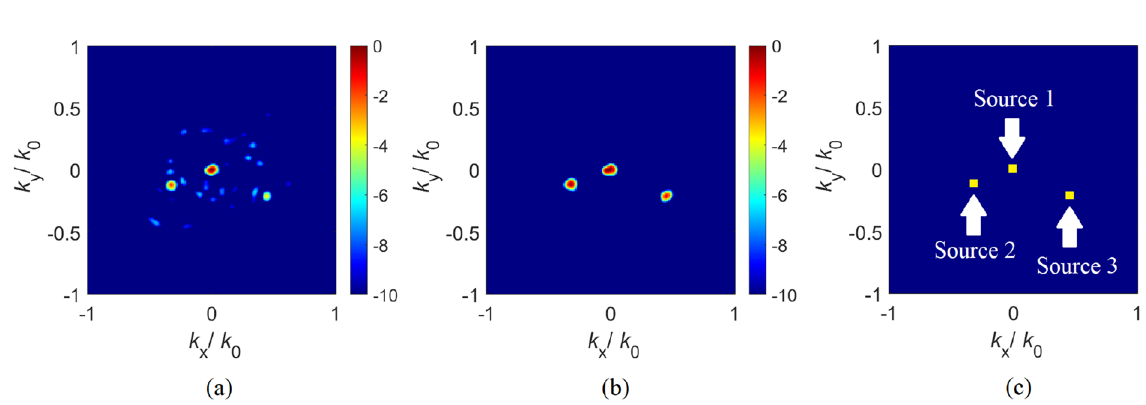
Figure 9. Reconstructed DoA patterns using ( a ) initial cavity configuration ( b ) optimized (final) cavity configuration. Original distribution of sources (ground truth) is shown in ( c ). Colorbar: